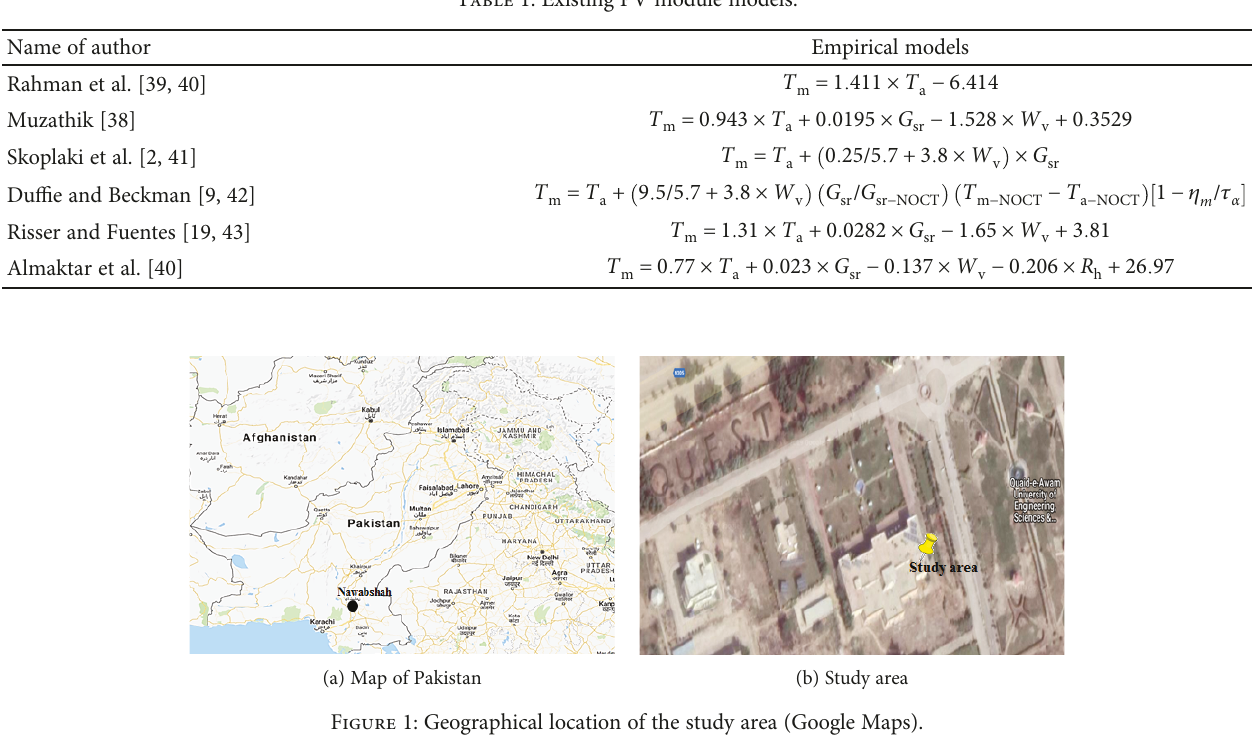
Table 1: Existing PV module models.